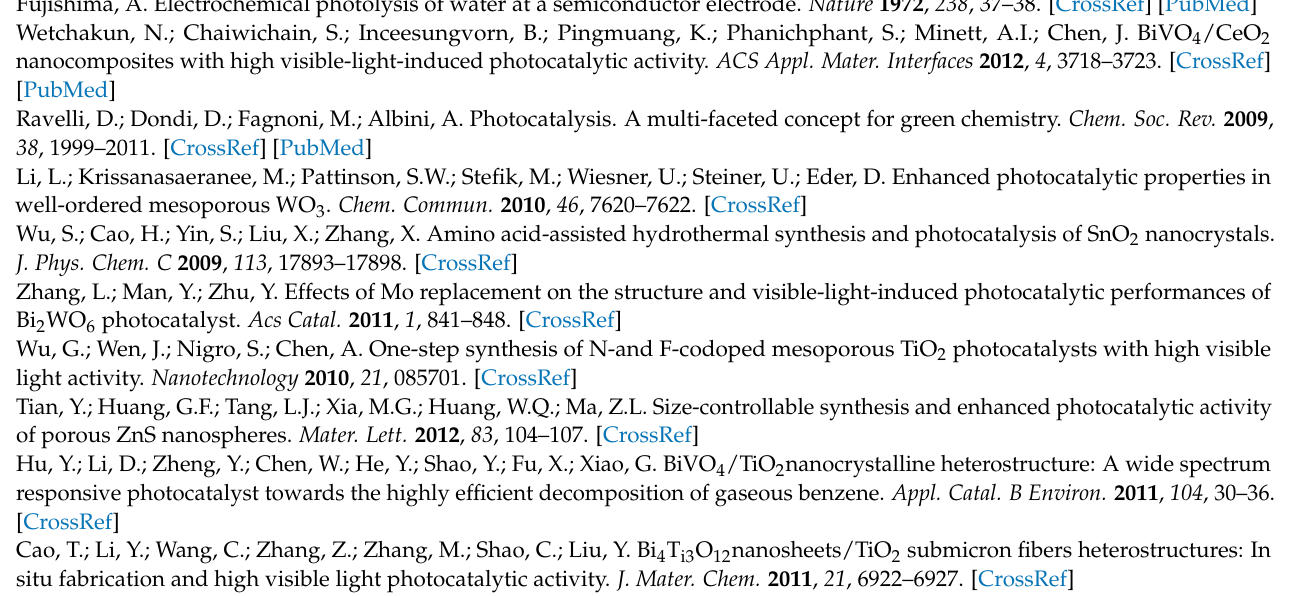
Figure S1: SEM image of (a) nonpurifiedCNT, (b) purified CNT, (c) AgIO 4 , (d) CNT/Ag 3 PO 4 @AgIO 4 . Figure S2: (a) Image of the dispersion of (A) CNT/Ag 3 PO 4 @AgIO 4 and (B) CNT-COO/Ag 3 PO 4 @AgIO 4 , in MB aqueous solution. (b) The adsorption of MB over: (A) CNT/Ag 3 PO 4 @AgIO 4 and (B) CNT- COO − /Ag 3 PO 4 @AgIO 4 composites. Figure S3: The photodegradation of MB over CNT-COO/ Ag 3 PO 4 @AgIO 4 with different CNT-COO contents. Figure S4: The photodegradation of different or- ganic dyes over CNT-COO − /Ag 3 PO 4 @AgIO 4 -5%, under sunlight irradiation. Figure S5: Regression curves of − ln(Ct/Co) versus irradiation time for CNT-COO − /Ag 3 PO 4 @AgIO 4 -5% under different light intensities (A) 100%, (B) 75%, (C) 50%, (D)